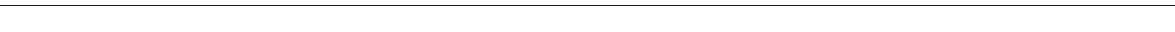
Fig. 2 C9ORF72 and p62 promote stress granule clearance by autophagy. a Percentage of cells containing stress granules in cells treated with control or p62 siRNA after 30 min arsenite, or one hour after removal of arsenite ( n = 3, mean ± SD, Student ’ s t -test). b Representative images of stress granules used in ( a ). c Percentage of cells containing stress granules in cells treated with control or C9ORF72 siRNA after 30 min arsenite, or one hour after removal of arsenite ( n = 3, mean ± SD, Student ’ s t -test). d Representative images of stress granules used in ( c ). e Quanti fi cation of FUS levels in cytoplasmic and nuclear extracts of cells treated with siRNA targeting p62, ATG5, ATG7, or control siRNA ( n = 5, mean ± SD, Student ’ s t -test). f Representative western blot of ( e ). g Proximity ligation assay for p62 and FUS in arsenite-treated cells transfected with control siRNA or siRNA targeting FUS. Scale bar = 10 µ m. h Immuno-electron micrographs of FUS and FMRP in cells treated with arsenite; arrows highlight antibody labeling within indicated stress granule-like structures. i Immuno-electron micrographs of p62 in cells treated with arsenite. j Immuno-electron micrographs of p62 (12 nm gold) and FUS (18 nm gold) in cells treated with arsenite; arrows highlight co-labeled structures. Scale bar = 100 nm. k Quanti fi cation of 46 randomly selected immuno-electron micrographs co-labeled with p62 and FUS as in ( j ). Each electron-dense stress granule-like structure, autophagolysosome-like organelle or 50 nm radius area of cytoplasm with label was quanti fi ed as being labeled with p62 alone, FUS alone, or both p62 and FUS. l 3D reconstruction of Z-stack confocal images of cells. Images are zoomed-in on stress granules labeled with the indicated antibodies or fl uorescent proteins (GFP-LC3). m Quanti fi cation of the percentage of p62 punctae co-labeled with stress granule markers and the percentage of stress granules with co-localized or docked p62 (quanti fi ed 12102 p62 punctae and 12627 stress granules, n = 6, mean ± SD, Student ’ s t -test). n Confocal image of endogenous C9ORF72 and p62 in cells treated with or without arsenite. Scale bar = 10 µ m. o Quanti fi cation of the percentage of C9ORF72 punctae overlapping with p62 in cells treated with or without arsenite (quanti fi ed C9ORF72 punctae without arsenite: 2688, with arsenite: 3778 punctae; p62 punctae without arsenite: 1805, with arsenite: 2942, n = 2, mean ± SD, Student ’ s t -test). HeLa cells were used in all